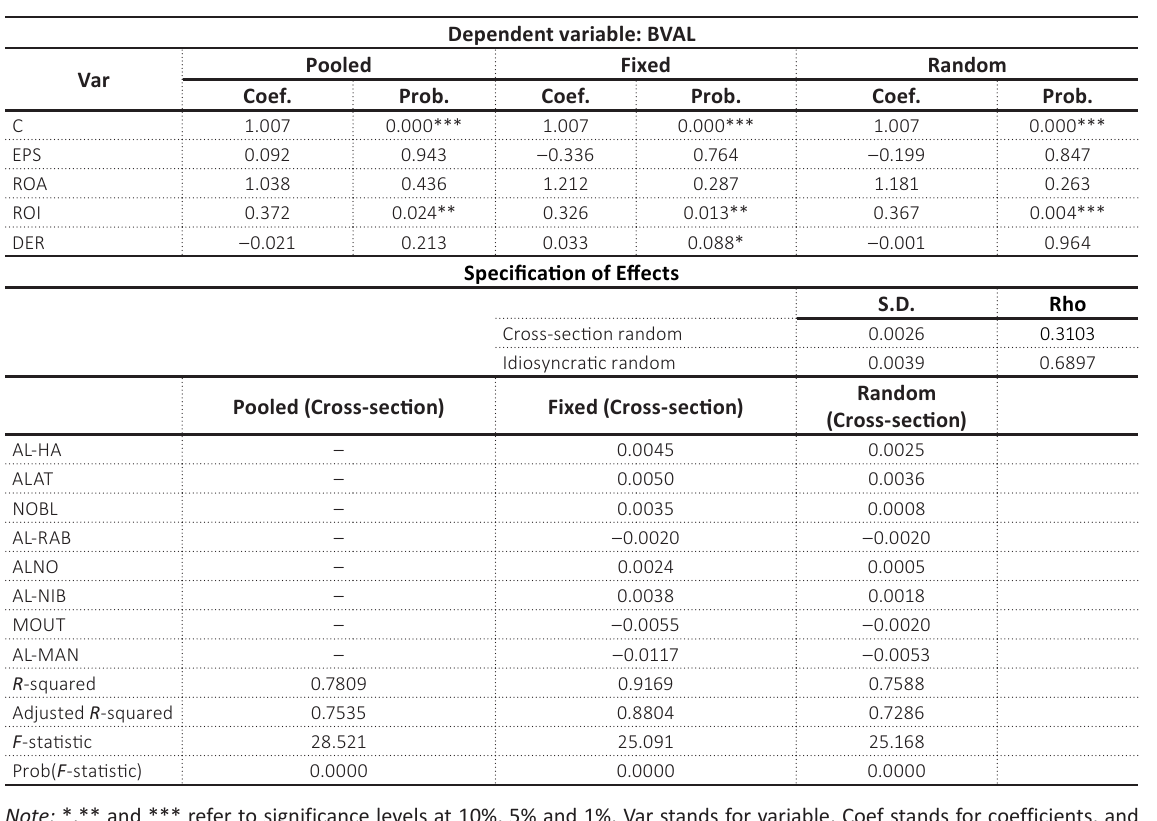
Table 4. Panel least square regression